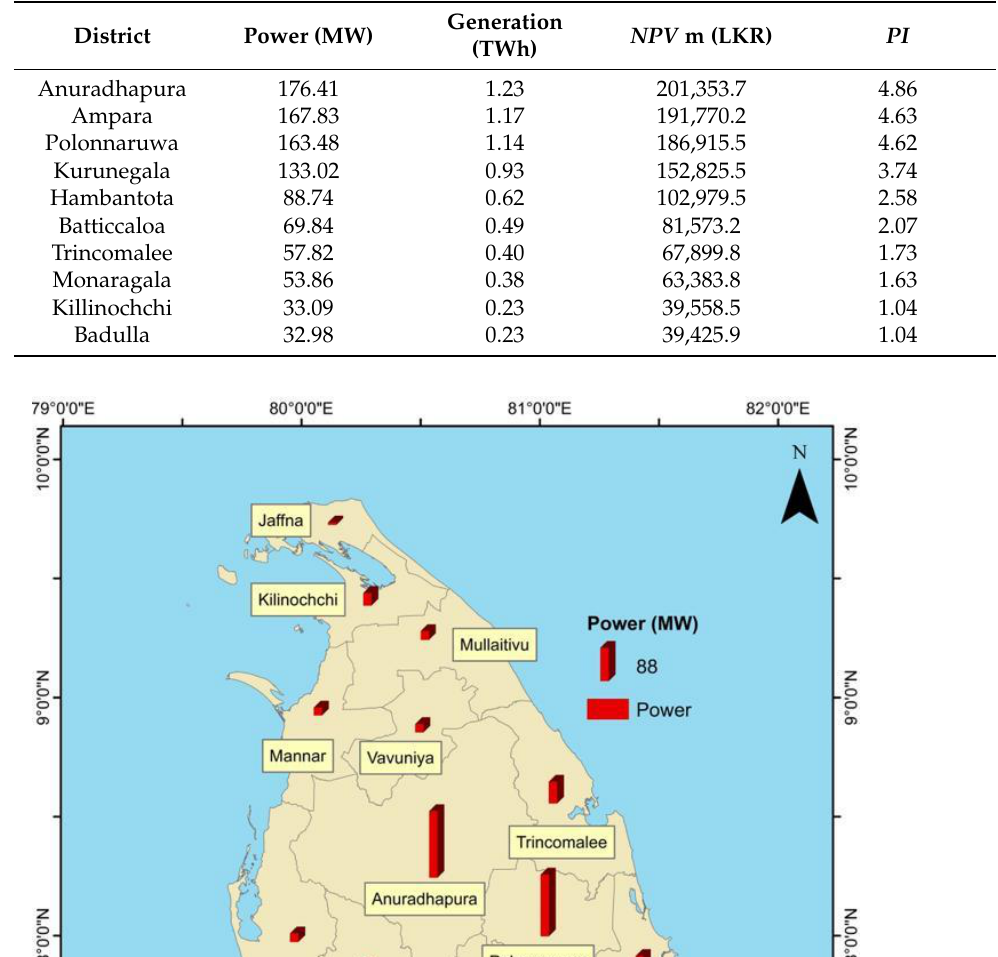
Table 4. Location, electrical power, electricity generation, NPV , and PI of GFC/ST plants with a